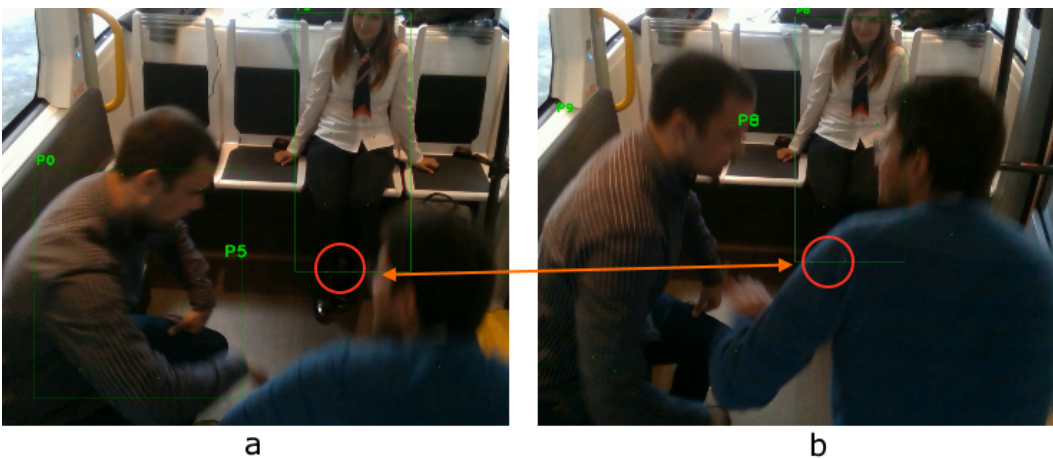
Figure 6. Despite the occlusion, the two leg joints of the girl are being approximately reconstructed ( b ) by their relative location in the previous frame ( a ).